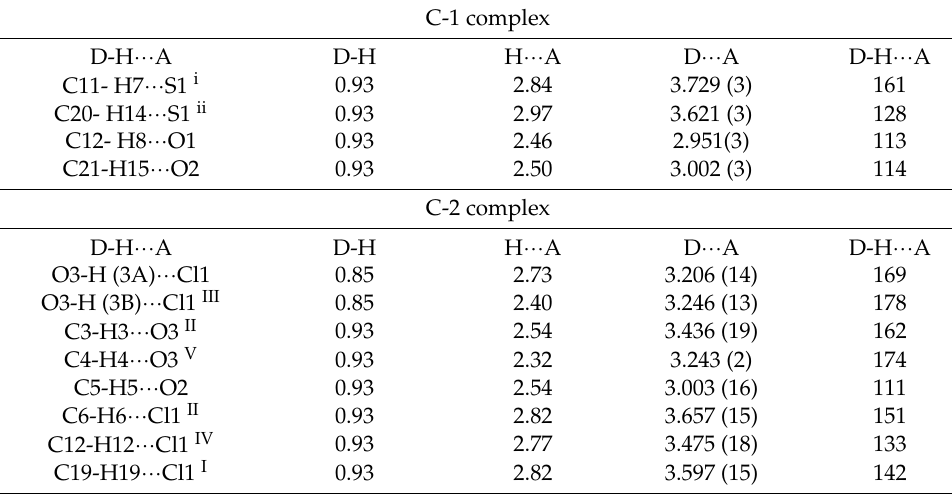
Table 2. Hydrogen-bond geometry (Å, ◦ ) in C-1 and C-2 complexes.